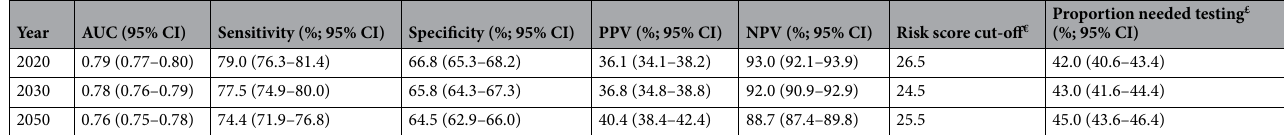
Table 2. Performance of the Qatari diabetes risk score at three different time points: 2020, 2030, and 2050. AUC area under the curve; CI confidence interval; PPV positive predictive value; NPV negative predictive value. € The risk score cut-off was chosen based on the maximum sum of sensitivity and specificity. £ Proportion of individuals who had a risk score greater or equal to the cut-off value.